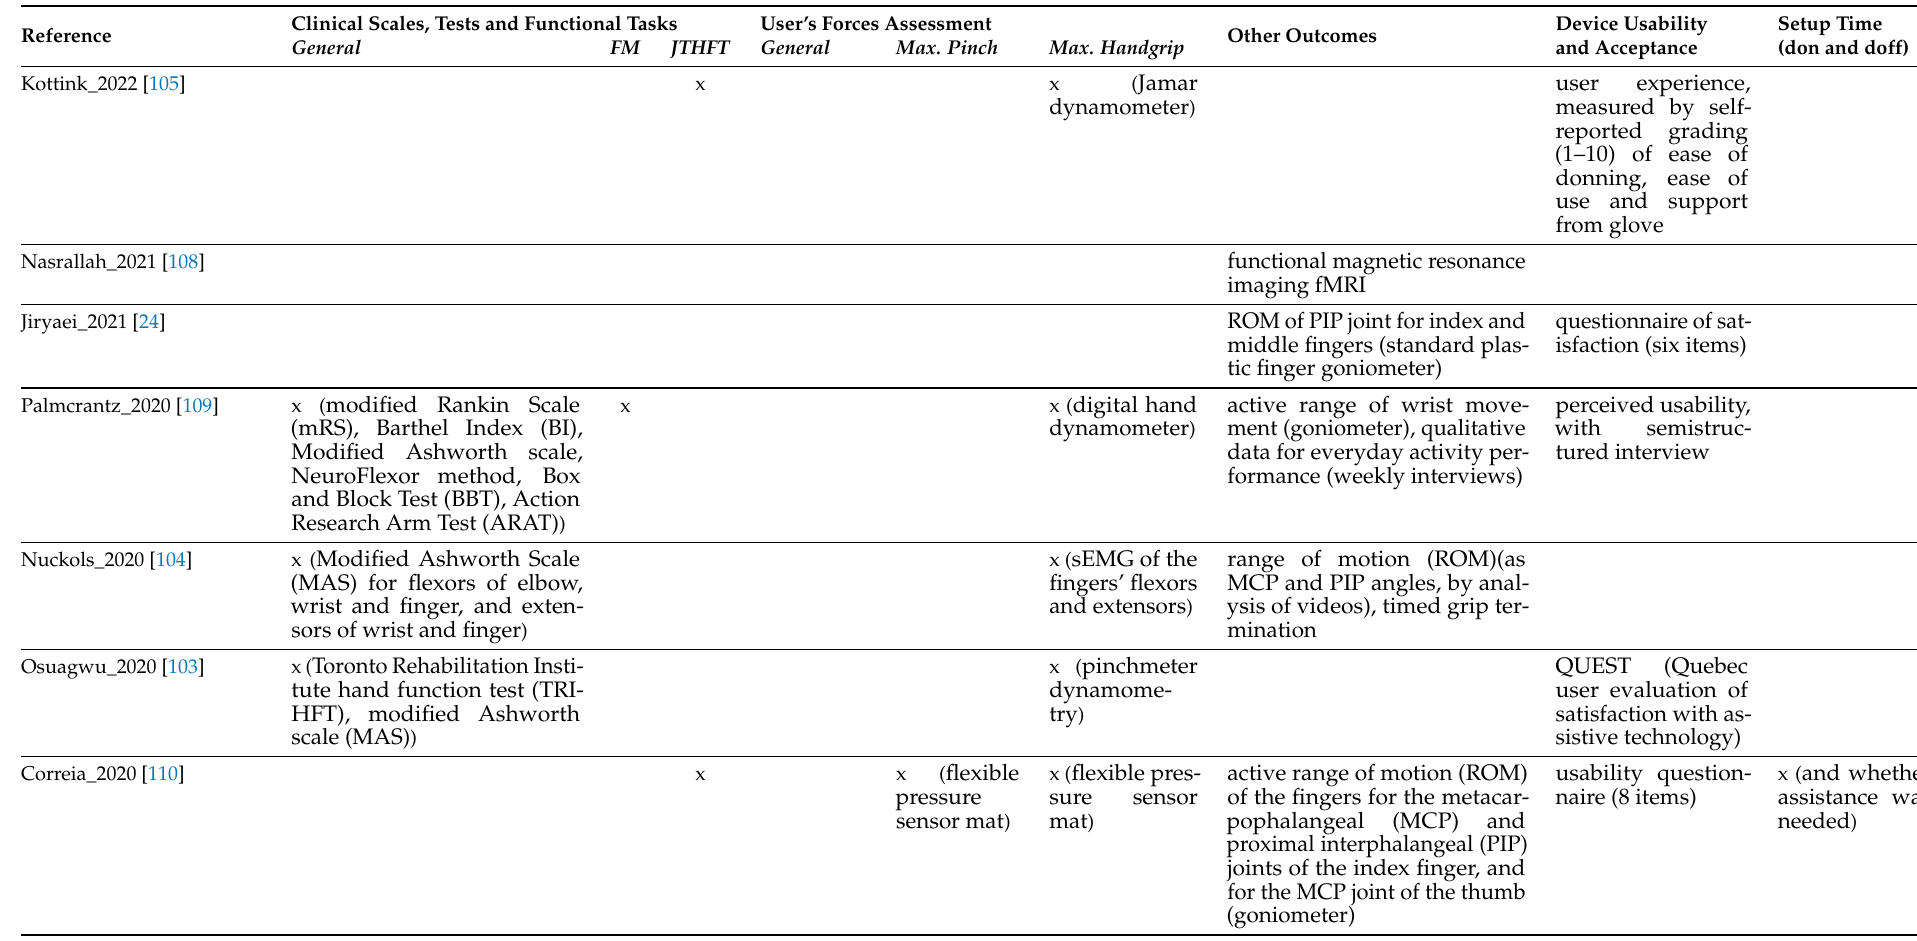
Table 3. Analysis of documents classified as clinical studies or trials. The table collects adopted clinical scales, tests, and evaluated functional tasks (with detail